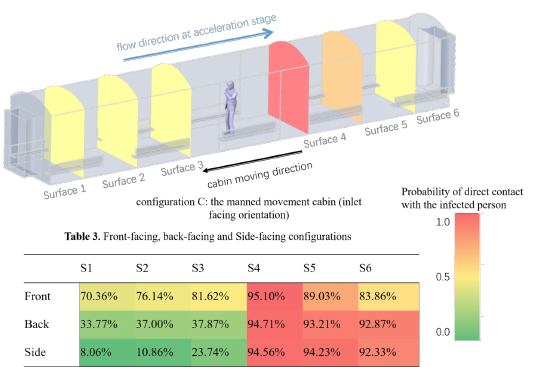
Figure 9 . Flow graph of six droplet sizes in three different facing